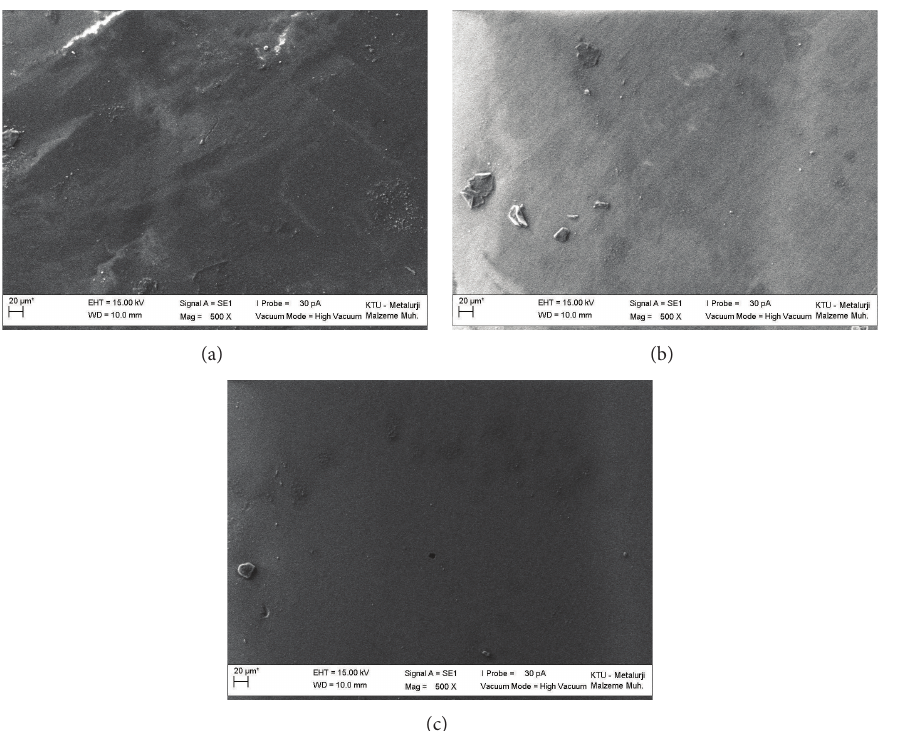
Figure 1: SEM evaluations of the samples with RC before UV. (a) Compomer, (b) nanofilled composite, and (c) microhybrid composite (Mag × 500).